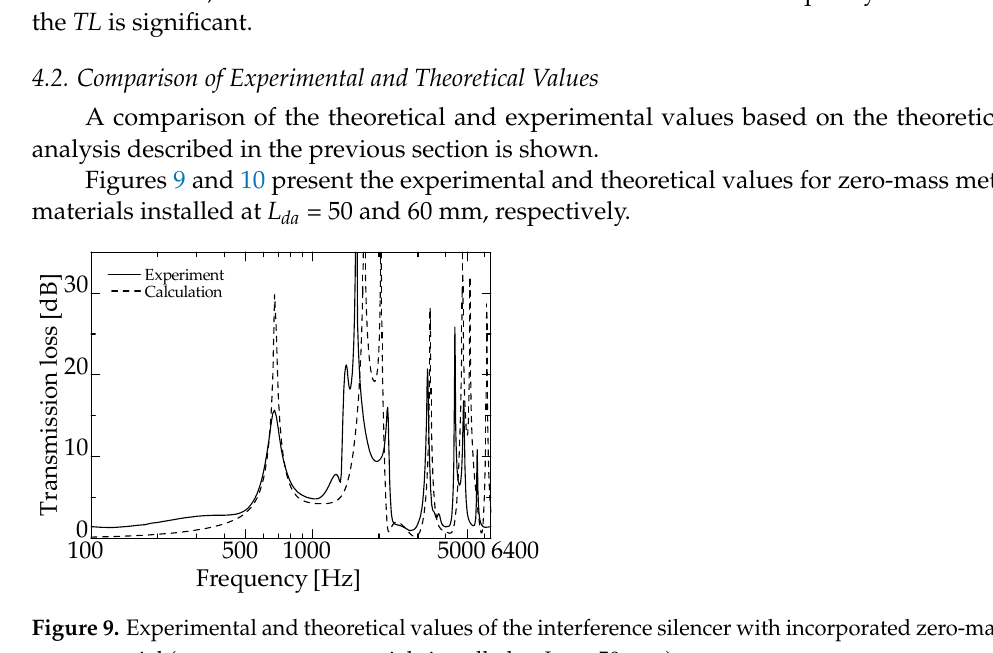
Figure 10. Experimental and theoretical values of the interference silencer with incorporated zero- mass metamaterial (zero-mass metamaterials installed at L da = 60 mm).